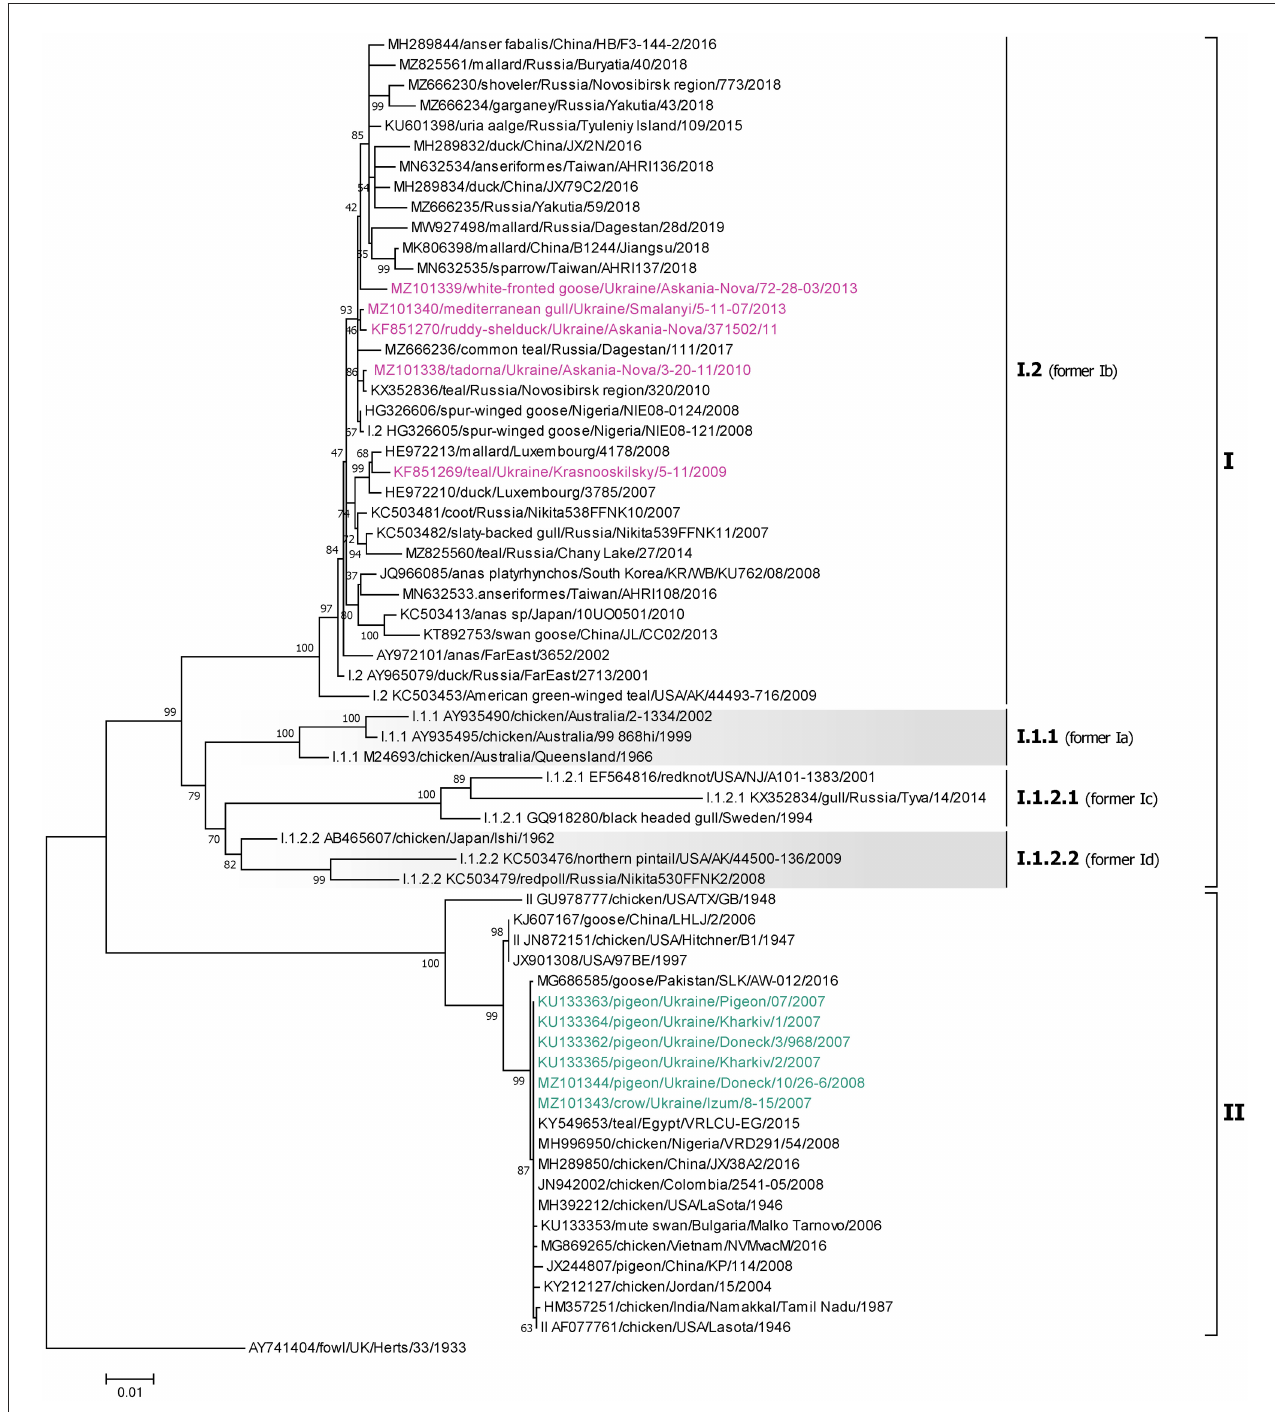
FIGURE4 Phylogenetic analysis of NDV genotype I and II class II isolates based on the complete fusion gene sequences constructed with the maximum likelihood method with 1,000 bootstrap replicates. The analysis involved 65 nucleotide sequences (a sequence from genotype IV AY741404/fowl/UK/Herts/33/1933 was included as an outgroup). All positions containing gaps and missing data were eliminated. There were a total of 1,661 positions in the final data set. The isolates used in this study are shown in pink (genotype I) and teal (genotype II). The Roman numerals on the right of the phylogenetic tree represent the respective sub-genotype for each isolate in accordance with the current classification (5) and the former nomenclature (58) is listed in parenthesis for reference.